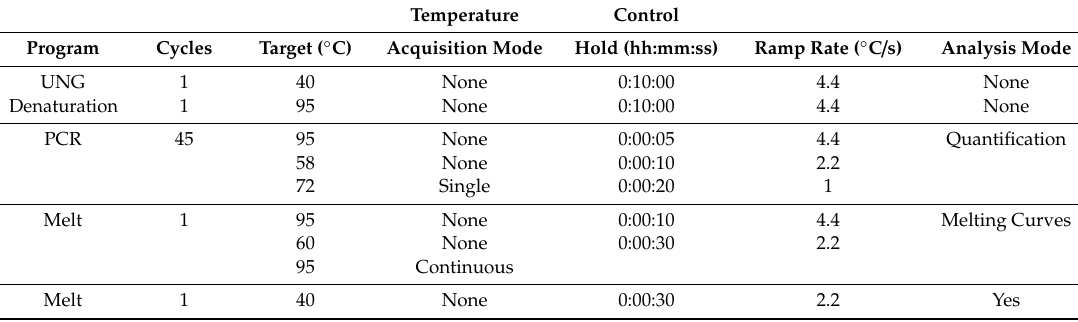
Table 3. Thermal cycling parameters.